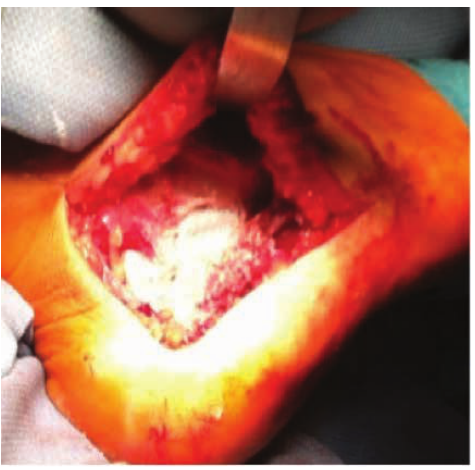
Figure 6: Intraoperative insertion of CERAMENT into the humerus